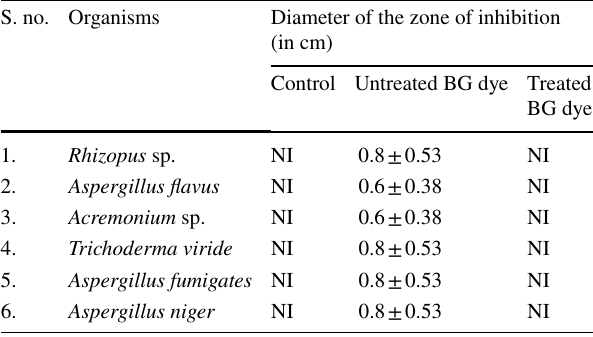
Table 2 Fungal toxicity of the untreated and treated dye